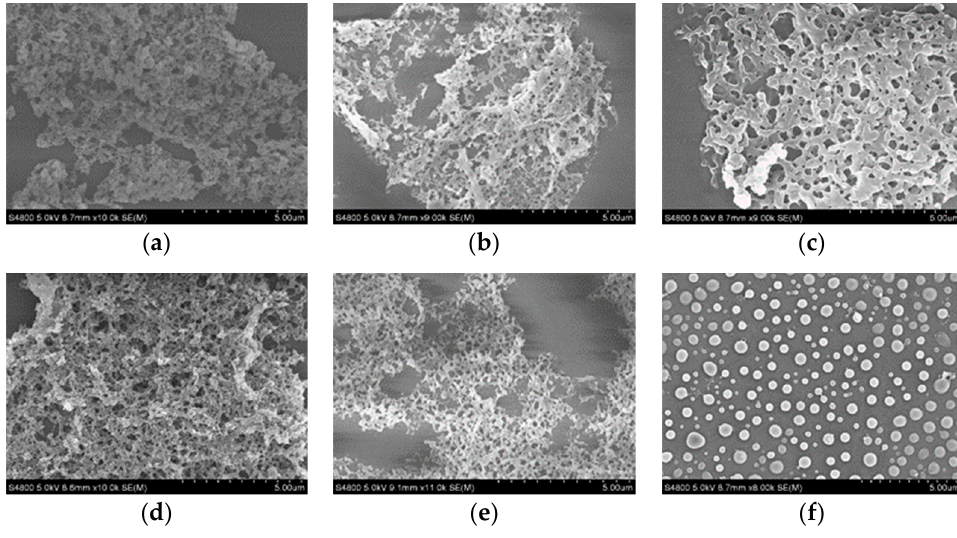
Figure 2. SEM images of ( a ) precipitated SRL without excipient; ( b ) HPMC; ( c ) HPMC with SDS; ( d ) Lactose; ( e ) PVP; ( f ) PVP-SDS.